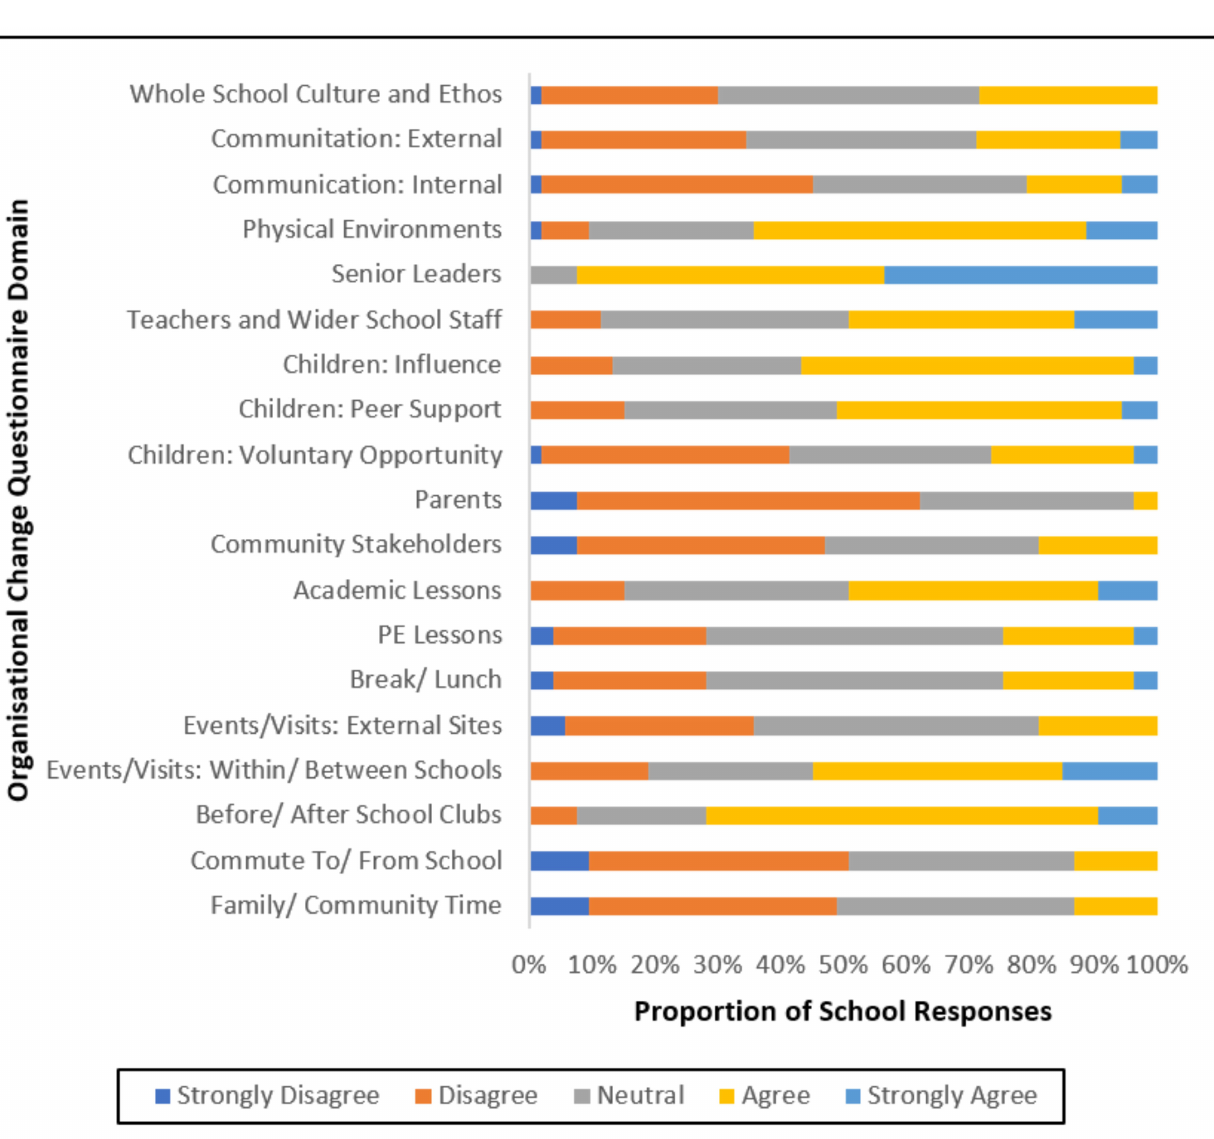
Figure 2. Descriptive statistics of the baseline measures of organisational changes to physical activity